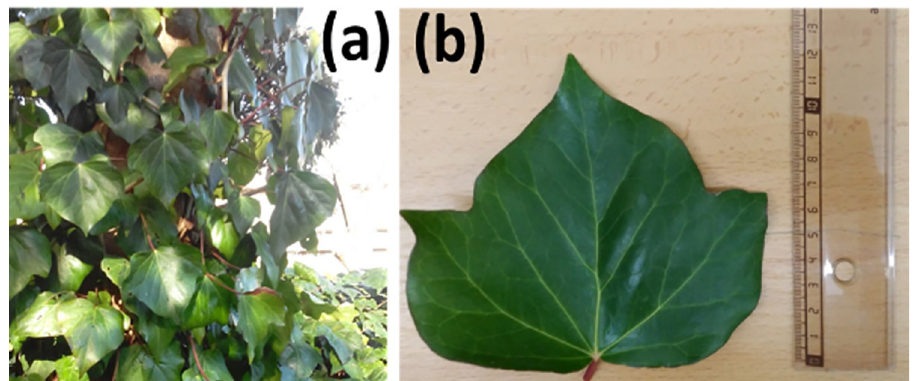
Fig 1. Plant sample used for the polarimetric analysis: (a) Hedera maroccana plant; (b) Hedera maroccana measured leaf (Sample A).